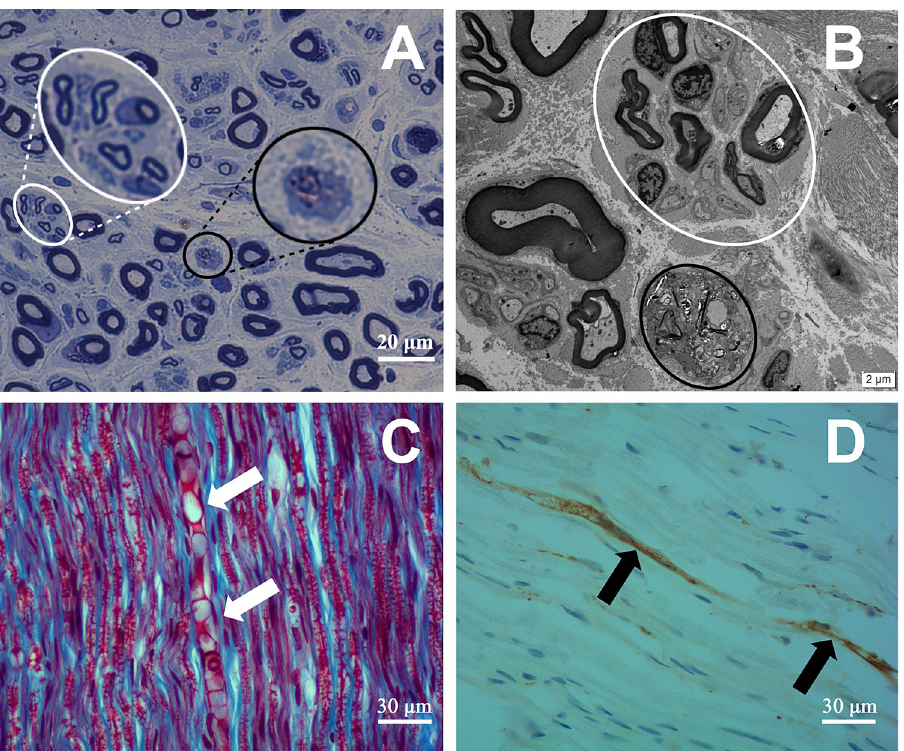
Fig 5. Spectrum of findings seen on sural nerve biopsies in N 2 O-induced peripheral neuropathy. (A) Semi thin section stained with toluidine blue shows axon degeneration (black circle) and nerve regeneration (white circle). (B) Electron microscopy shows axon degeneration (black circle) and nerve regeneration (white circle). (C-D) Masson trichrome staining showing acute axonal degeneration and formation of myelin ovoid evident on longitudinal sections (white arrows). This patient had CD68-positive mononuclear cells within the fascicular.